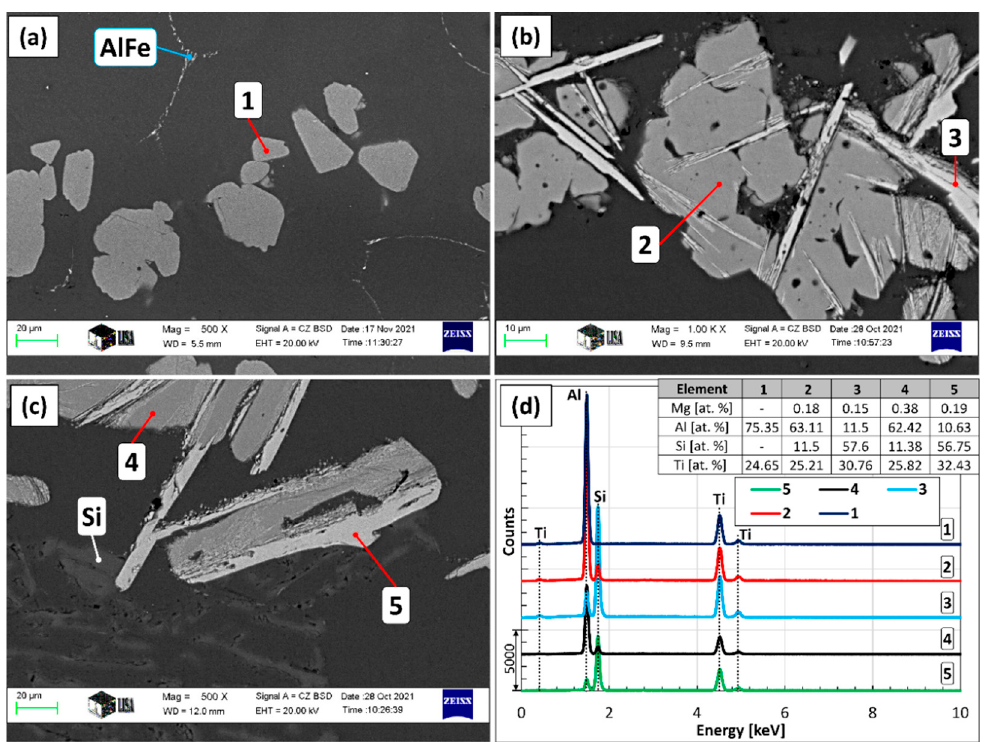
Figure 7. ( a ) SEM image of the Al-10%Ti master alloy, ( b ) the particles formed during experiment A2 and ( c ) A1, ( d ) the results of the EDS analysis at the indicated points.